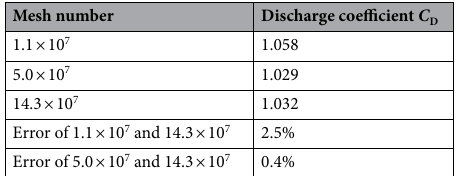
Table 1. Simulation results error under different numbers of mesh.